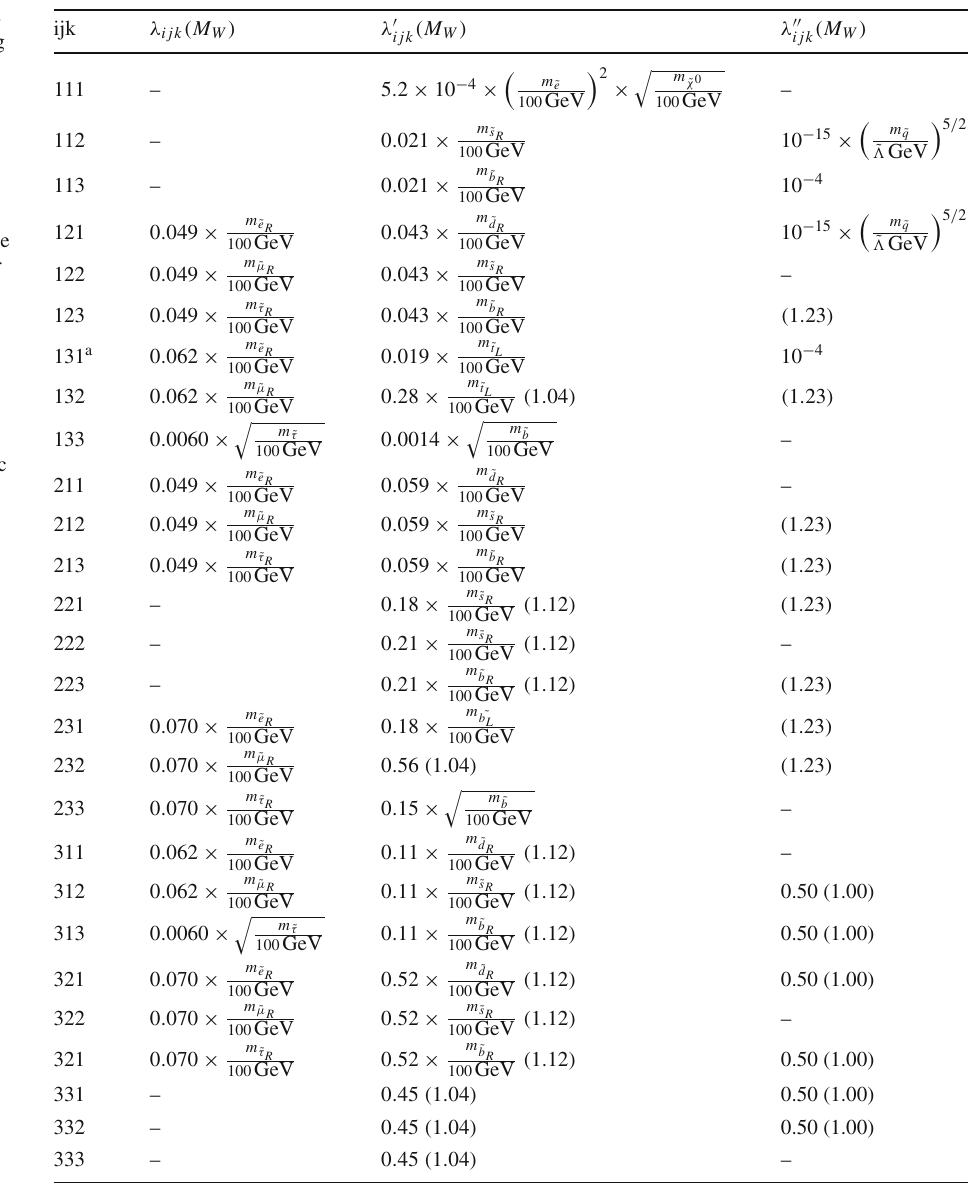
Table 13 Upper bounds on the magnitude of R -partiy violating couplings at the 2 σ confidence level, taken from [105]. The constraints arise from indirect decays. The concrete processes are described in detail in